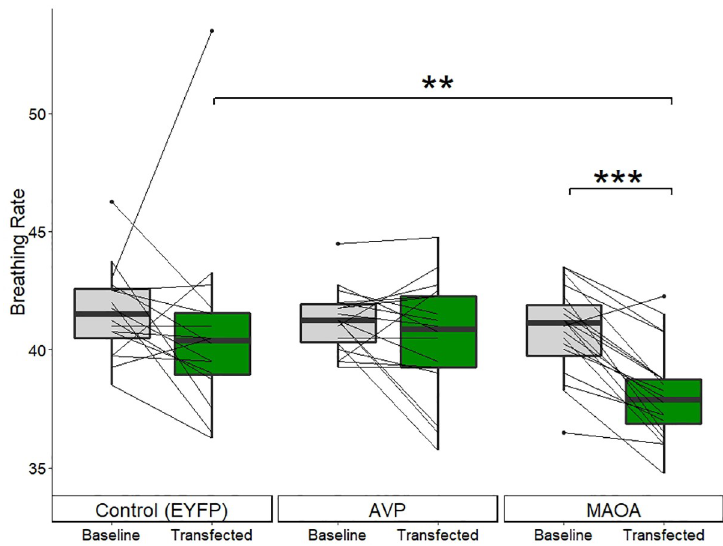
Fig 9. Respiration rate (opercular beats per 20 seconds) for the three constructs. Each line represents an individual showing their respiration rate (averaged across the two trials) before and after transfection. Only MAOA altered respiration rate; a drastic decrease compared to both baseline (within-subject comparison, N = 20) and to the control group (N = 16). � p � 0.05; �� p � 0.01; ��� p � 0.001.